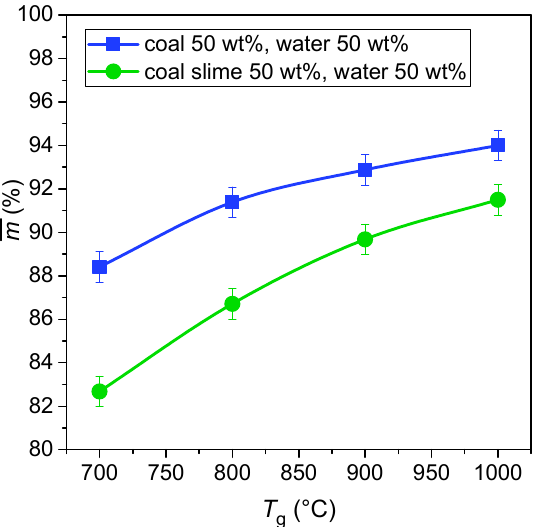
Figure 6. Relative indicator reflecting the degree of slurry droplet burnout ( R d = 2 mm) with varying temperature in the combustion chamber.